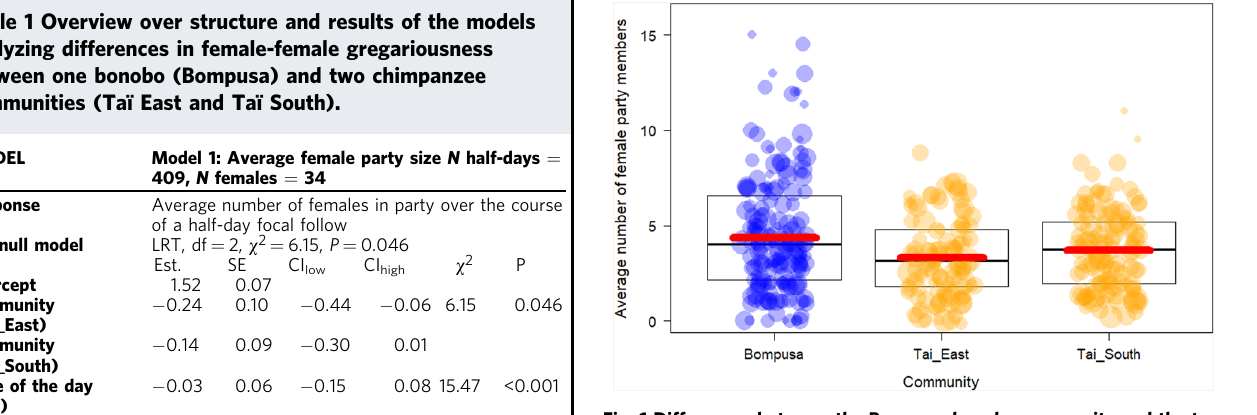
Fig. 1 Differences between the Bompusa bonobo community and the two Taï chimpanzee communities in the total number of adult females in the party of female focal individuals. The Bompusa bonobo community is depicted in blue and the two Taï chimpanzee communities are depicted in orange. Each dot represents a half-day focal follow and the size of the dots represents the number of data points (i.e. number of 30 min parties) for a given value. Boxes indicate the medians and the 25 and 75% quartiles. Bold red lines represent the model line controlling for time of the day and multiple sampling of the same individuals (Model 1).